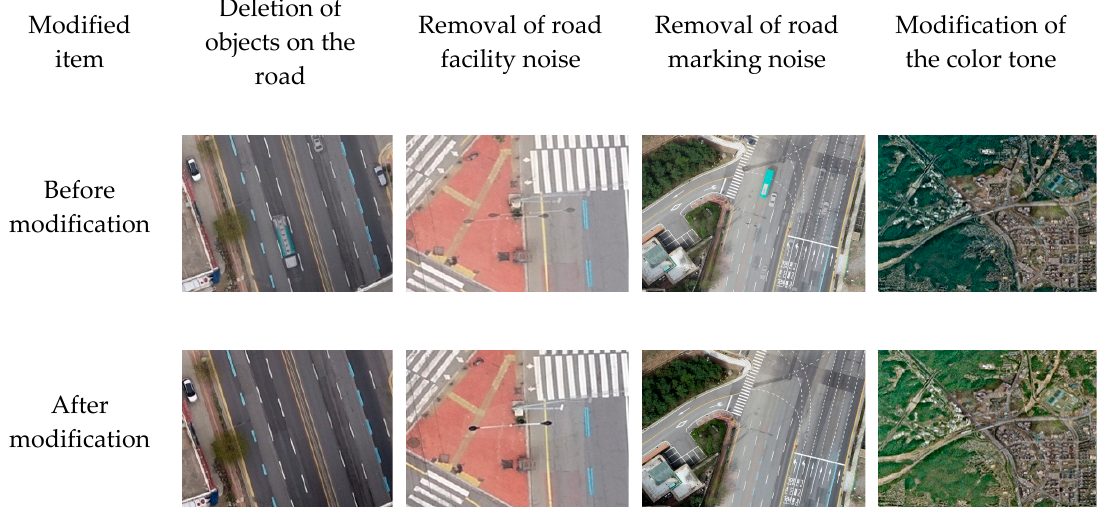
Figure 4. Orthoimage editing.